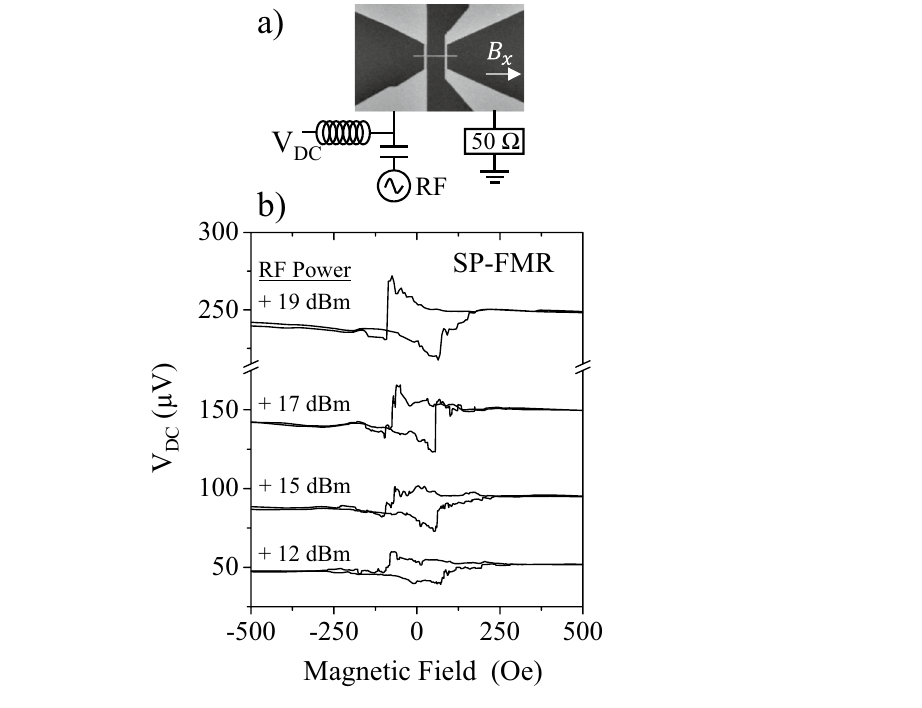
Figure 4. ( a ) Spin Pumping Ferromagnetic Resonance Experiment set up. The RF current is delivered through a Bias Tee and the DC voltage recorded through the DC contact of the Bias Tee. ( b ) Recorded curves for different SAW